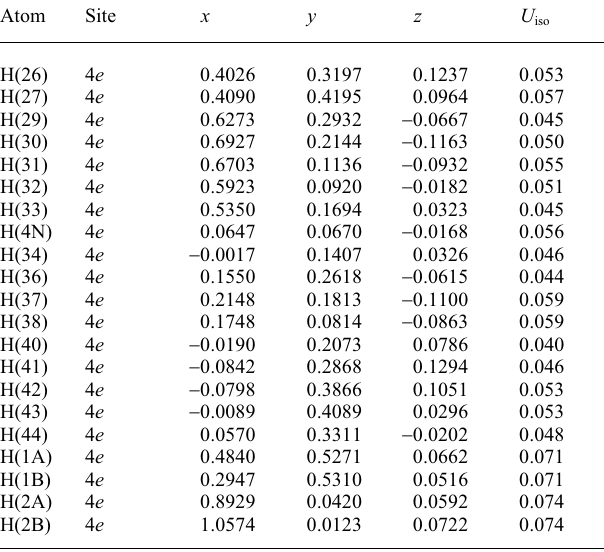
Table 2. Atomic coordinates and displacement parameters (in Å 2 ) . Atom